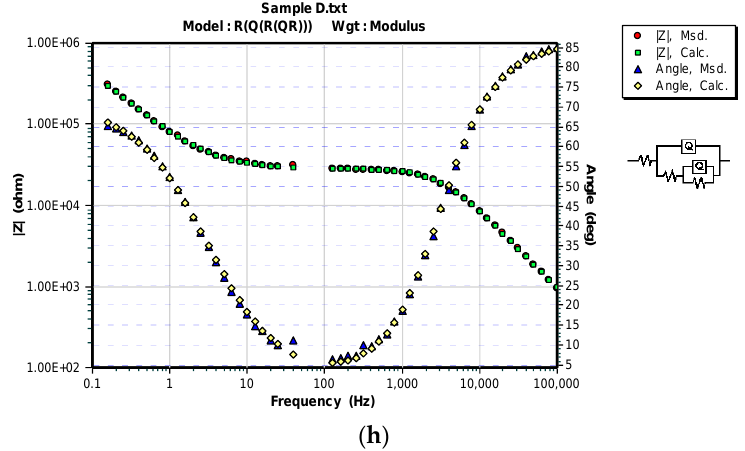
Figure 4. The Nyquist diagram ( a , c , e , g ) and Bode diagram ( b , d , f , h ) of tested powder coatings after 100 h immersion in 4% w/w NaOH solution: ( a , b ) Sample A; ( c , d ) Sample B; ( e , f ) Sample C; ( g , h ) Sample D.